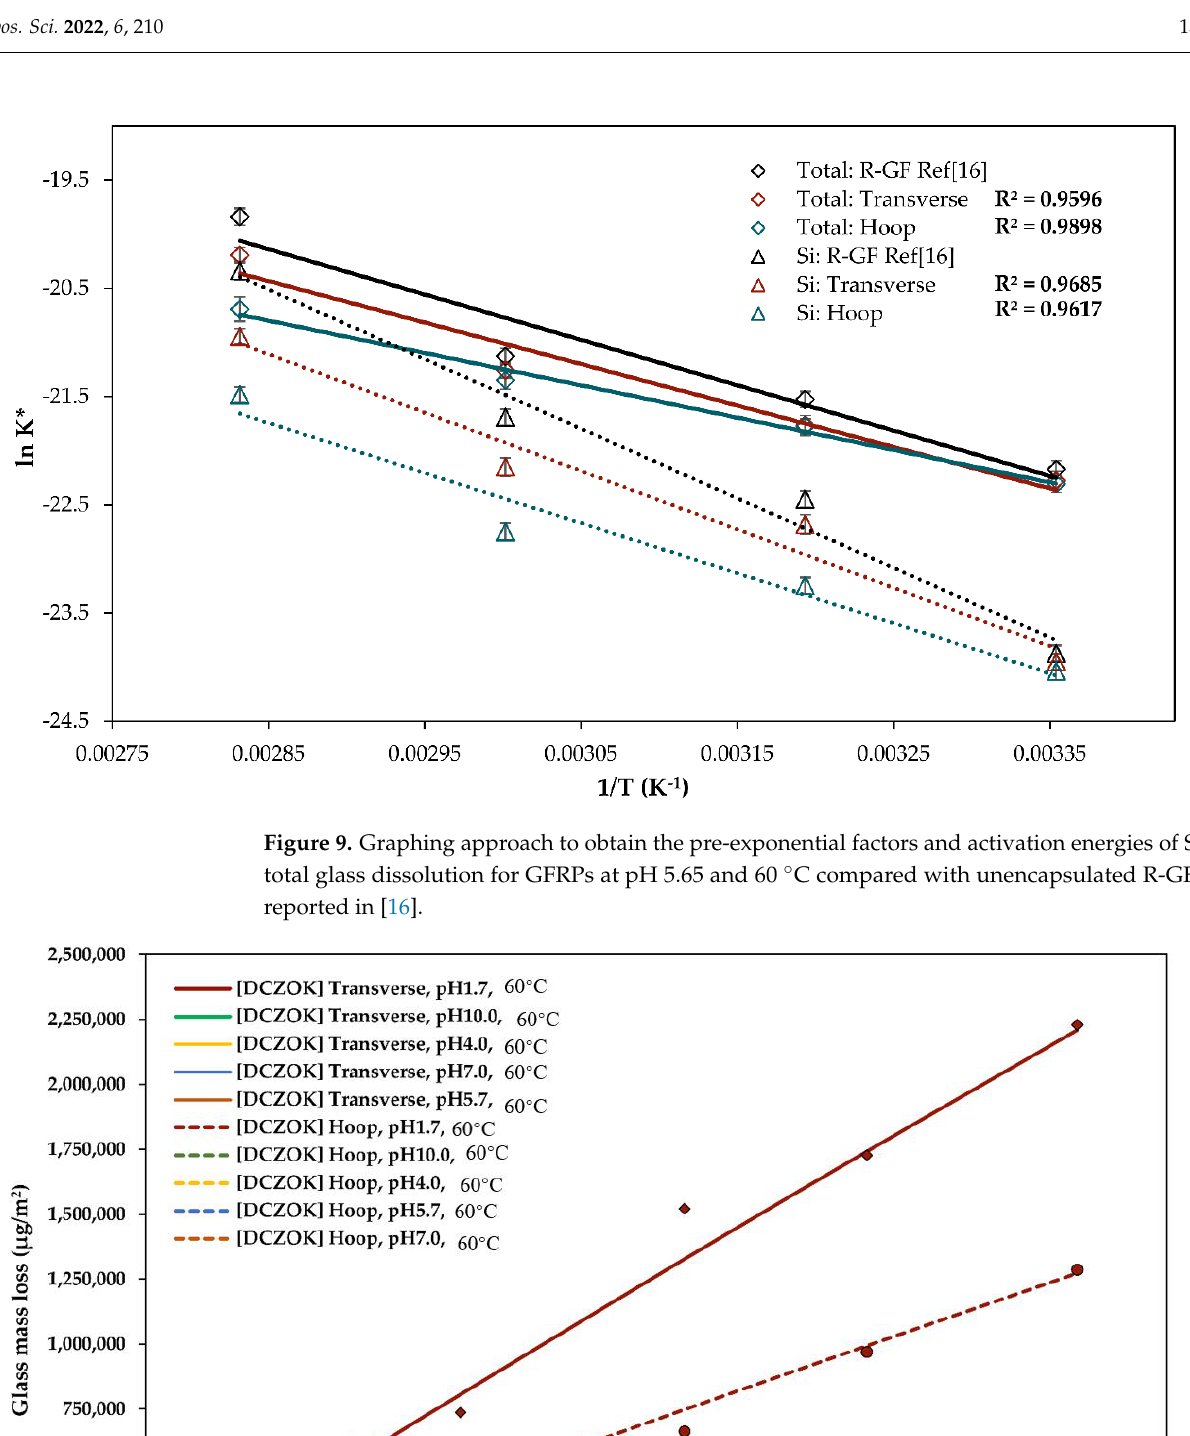
Figure 11. Glass dissolution kinetics at various temperatures: experimental data and modeled DCZOK dissolution curves for GFRP plates. 4. Discussion Effect of the environment. As in the case of R-GFs [16], for the studied R-GFRPs, the temperature shows a similar Arrhenius-type influence on the kinetics, increasing the rate of dissolution exponentially with increasing temperature. The DCZOK model was able to capture the effect of temperature on R-GFRPs well in both hoop and transverse orientations. Similar to R-GFs [16], R-GFRPs also showed a hyperbolic dependence on pH. Transverse specimens degraded much quicker at pH 1.7 than their hoop counterparts, and their integrity was destroyed within a week, as seen in Figure 4. Thus, R-GFRPs should